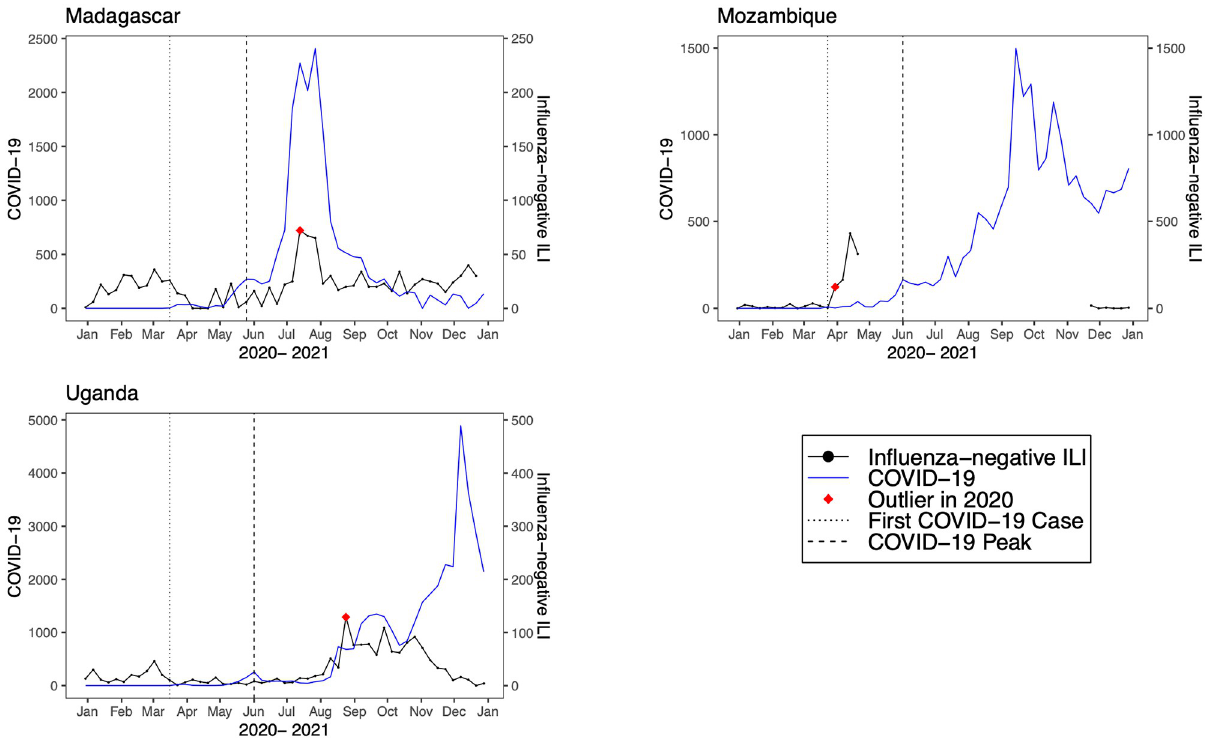
Fig 8. Observed trends in COVID-19 compared to influenza-negative influenza-like illness (ILI) in low-income countries. AU : InFig 8 : ThepanelforUgandaoverlapsthex (cid:0) axislabelfortheMadagascarpanel : Irecommendfixingthis : Trends in reported COVID-19 cases (blue line) and influenza-negative ILI cases (black line) during 2020. The vertical dotted black line indicates the week of the first COVID-19 case, the vertical dashed line indicates the week of the first COVID-19 peak, and the red diamond indicates the first detected influenza- negative ILI outlier in 2020.